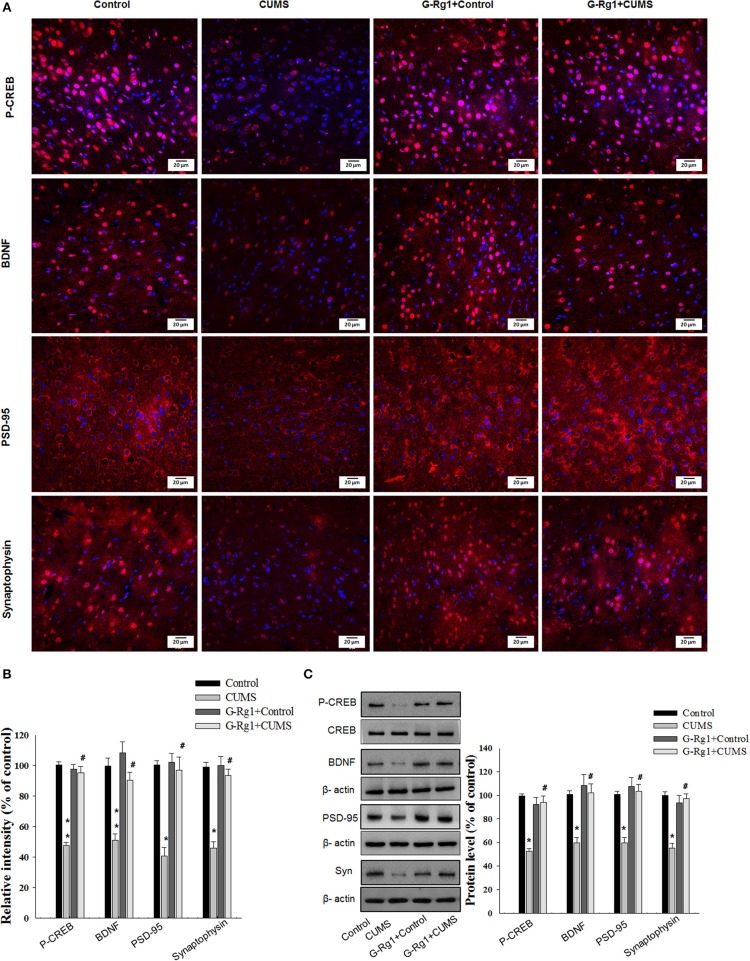
Ginsenoside-Rg1 up-regulated synaptic-related proteins within the vmPFC region as induced by CUMS-exposure. (A) Immunofluorescence analysis of phosphorylated CREB, BDNF, PSD-95, and synaptophysin in vmPFC regions and (B) histograms showing the fluorescence intensities in the vmPFC neurons of each group. Nuclei are stained with DAPI in blue. Scale bar is 20 μm. N = 6 per group. (C) Western blot analysis of phosphorylation levels of CREB and protein expression levels of BDNF, PSD-95, and synaptophysin within the vmPFC regions. Normalized intensity bands are presented as the means ± SEM. N = 6 per group. *P < 0.05, **P < 0.01 CUMS vs. Control group; #P < 0.05 G-Rg1+CUMS vs. CUMS group. G-Rg1, Ginsenoside-Rg1; Syn, Synaptophysin.